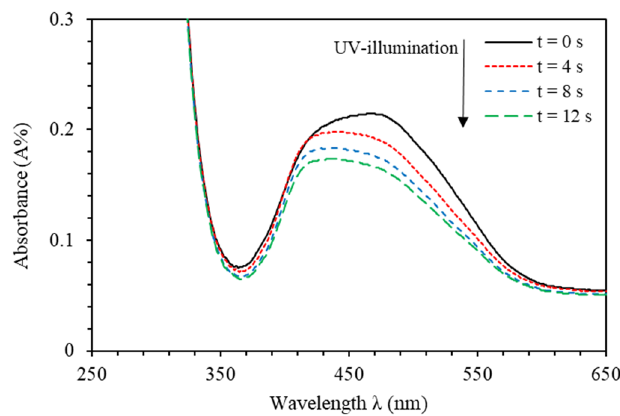
Figure 4. Absorbance spectra of PMMA-BDK-MR polymer composite thin film for various UV- illumination times, namely, natural trans -case, trans/cis -transformation case (1) after 4 s, trans/cis - transformation case (2) after 8 s and cis -state after 12